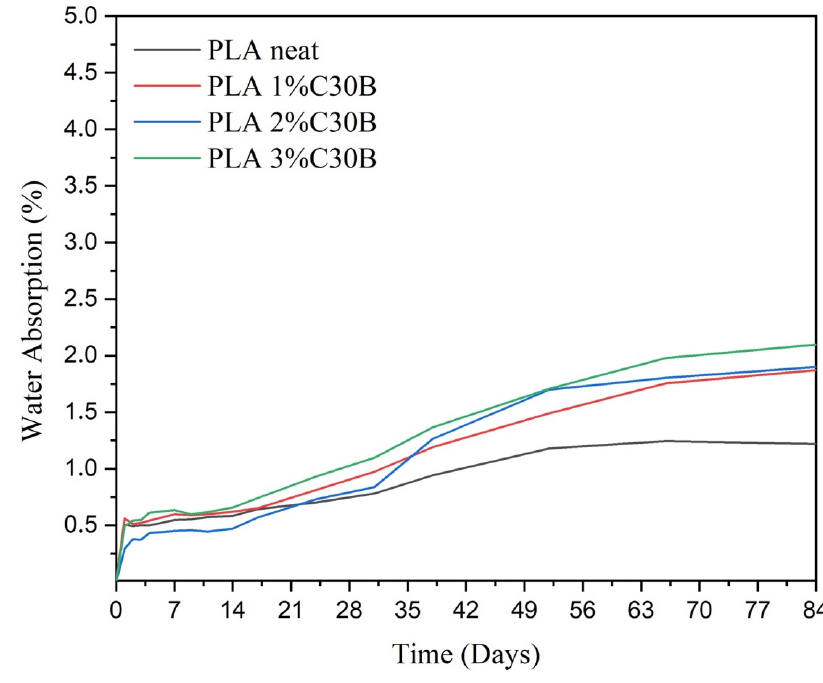
Figure 12. Water uptake of the PLA neat and PLA/C30B bionanocomposite films.